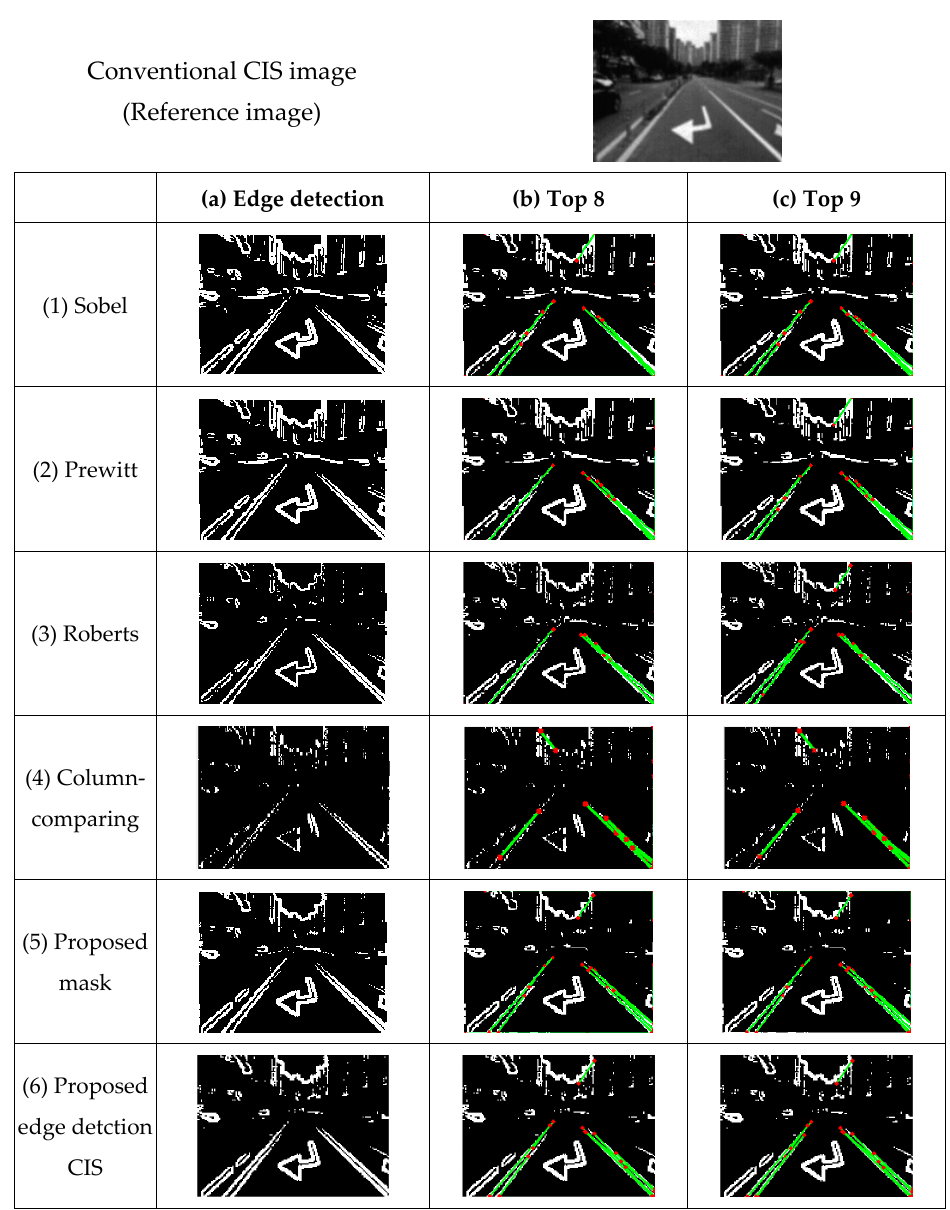
Figure 11. ( a ) Edge detection image and ( b ) Top 8 and ( c ) Top 9 of the lane detection image obtained from the conventional CIS image. Table 3. Degree of lane recognition of an image that ended the lane recognition (= how many of four center lanes are recognized).